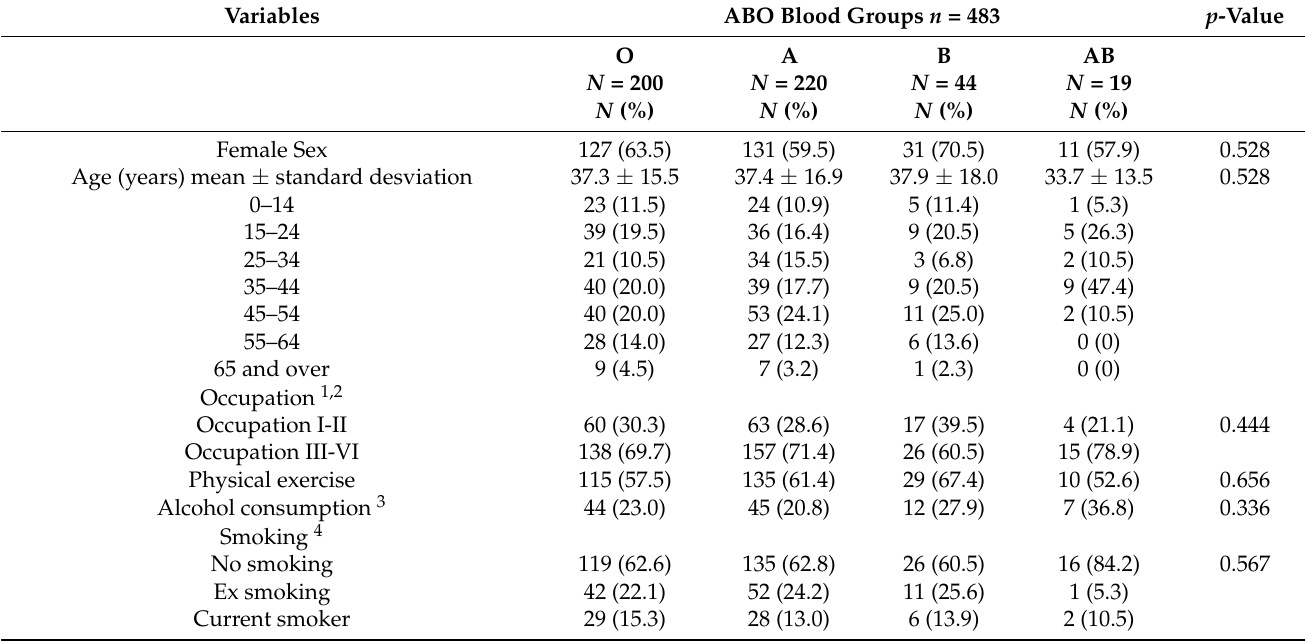
Table 1. Distribution of characteristics ABO blood groups in the subjects included October 2020. Borriana COVID-19 cohort 2020.